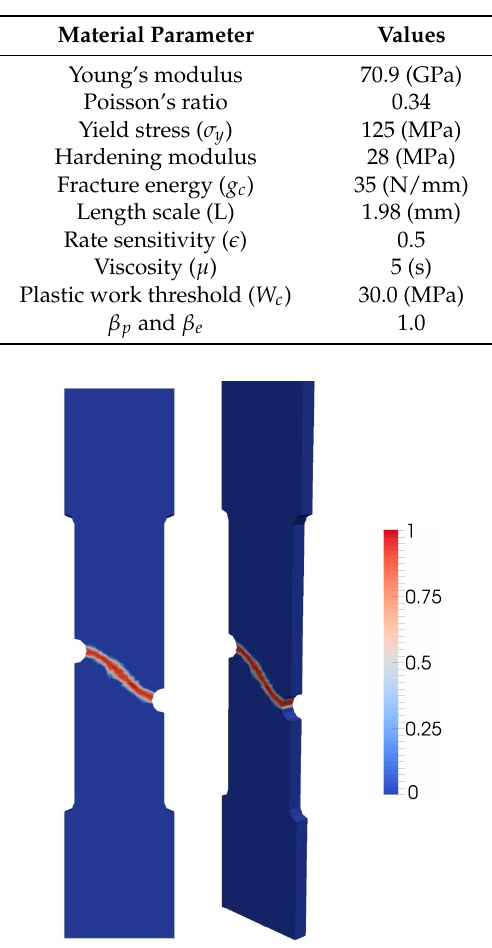
Figure 12. Contour plots of the phase field for the asymmetric notched sample.